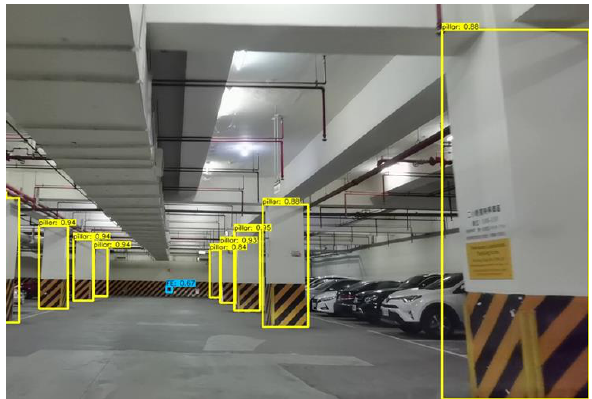
Figure 7. The results of YOLO-v3 object